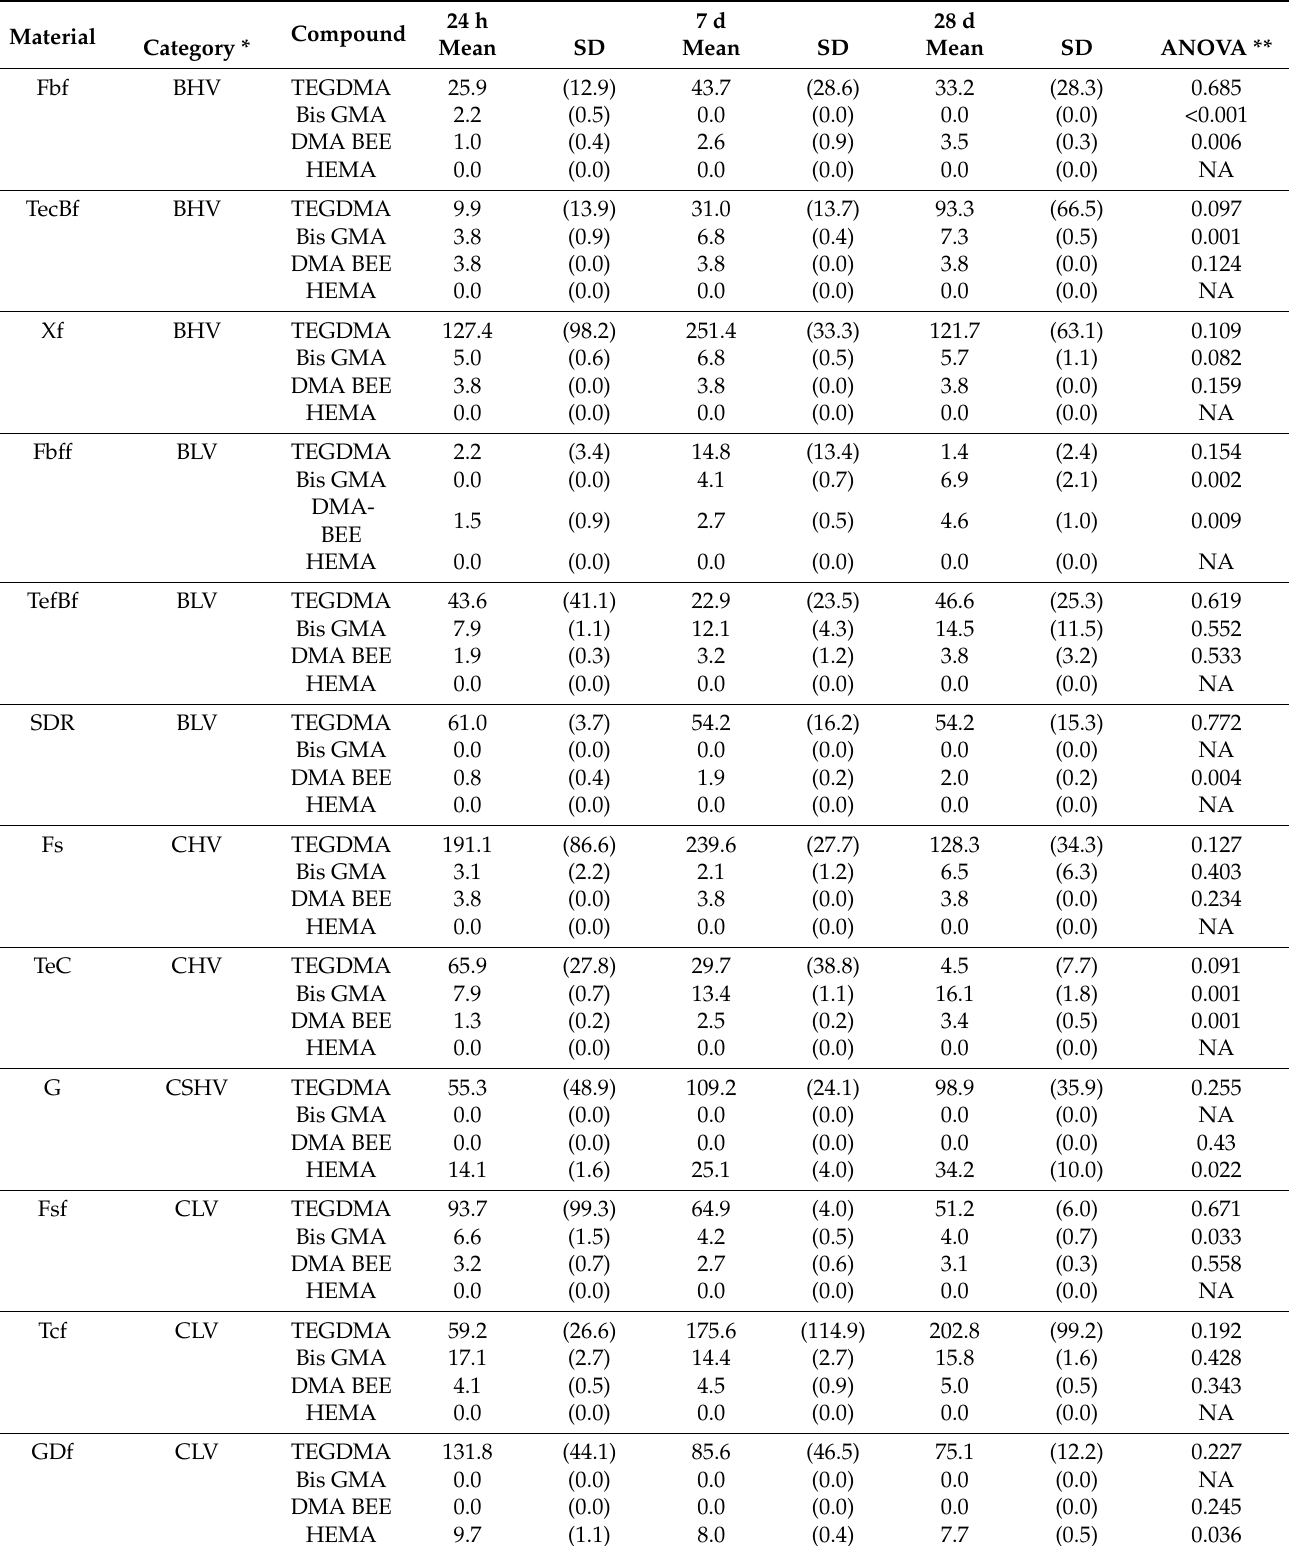
Table 2. Mean values (SD) of residual leachable compounds for each dental material at each time